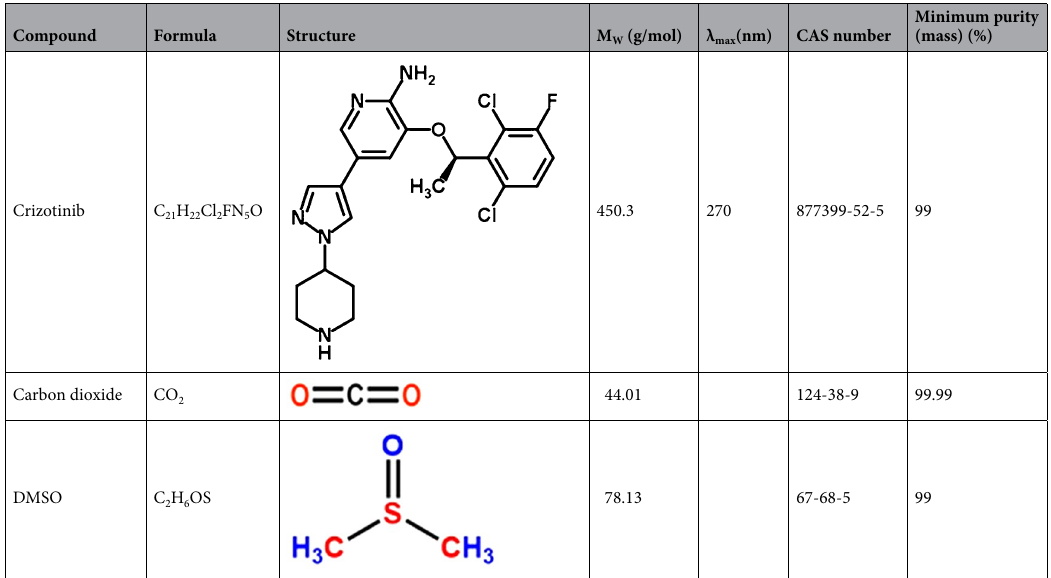
Table 1. Molecular structure and physicochemical properties of used materials.